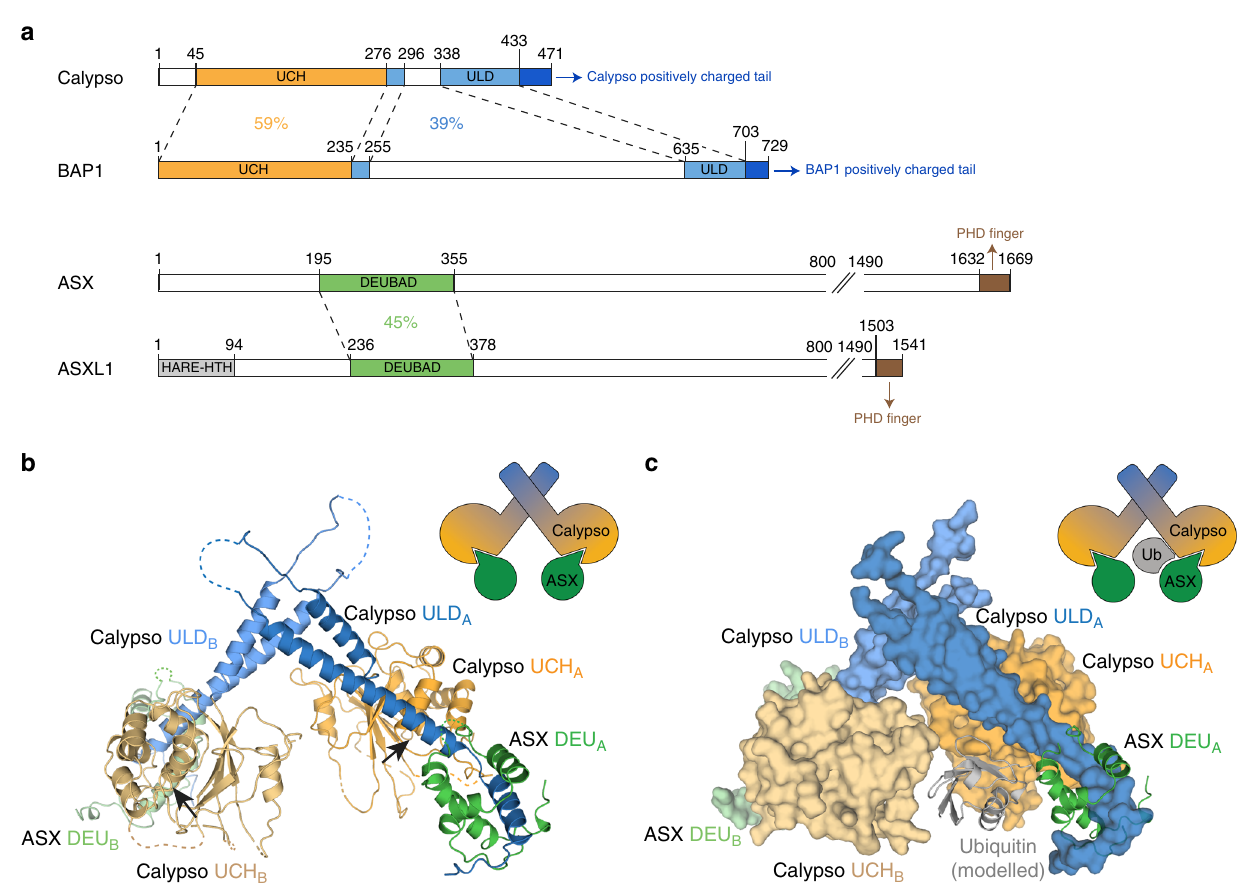
Fig. 1 Crystal structure of the Drosophila PR-DUB complex. a Schematic representing domain structure of human and Drosophila PR-DUB components. Sequence identity between the UCH and ULD domains of Calypso and BAP1, and between the Deubad domains of ASX and ASXL1 is indicated. FL, full- length; UCH, ubiquitin C-terminal hydrolase; ULD, UCH37-like domain; ASX, additional sex combs; ASXL1, ASX-like 1; PHD, plant homeodomain (see Supplementary Fig. 1a). b Structure of the Calypso – ASX complex (PDB code: 6CGA). The UCH and ULD domains of Calypso are coloured orange and blue, respectively. The Deubad domain of ASX is coloured green. Black arrows indicate the position of the active site cysteine residue in the respective